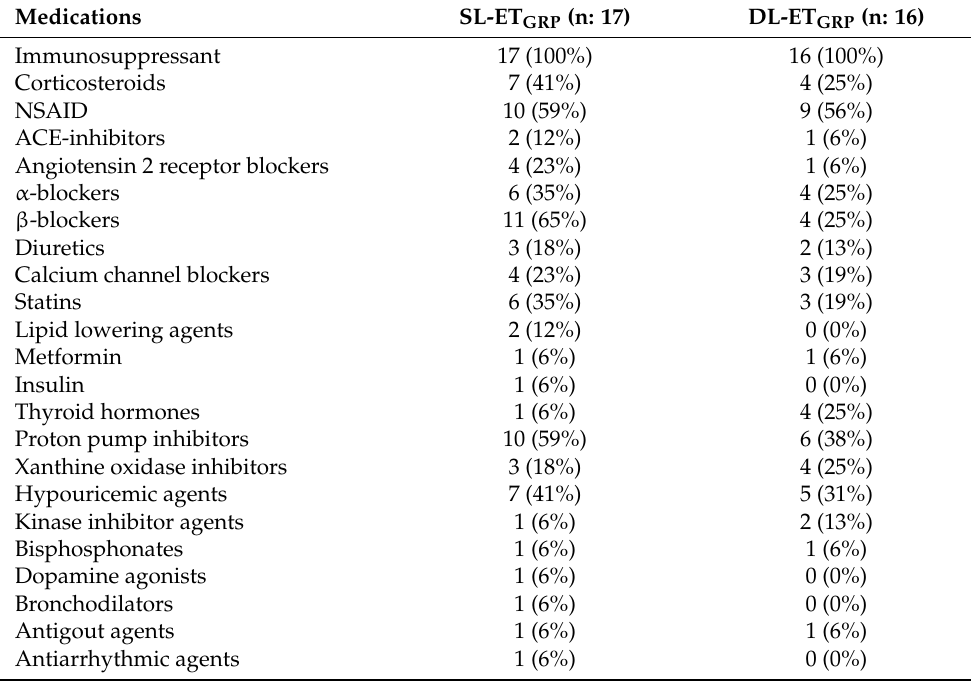
Table 2. Pharmacological